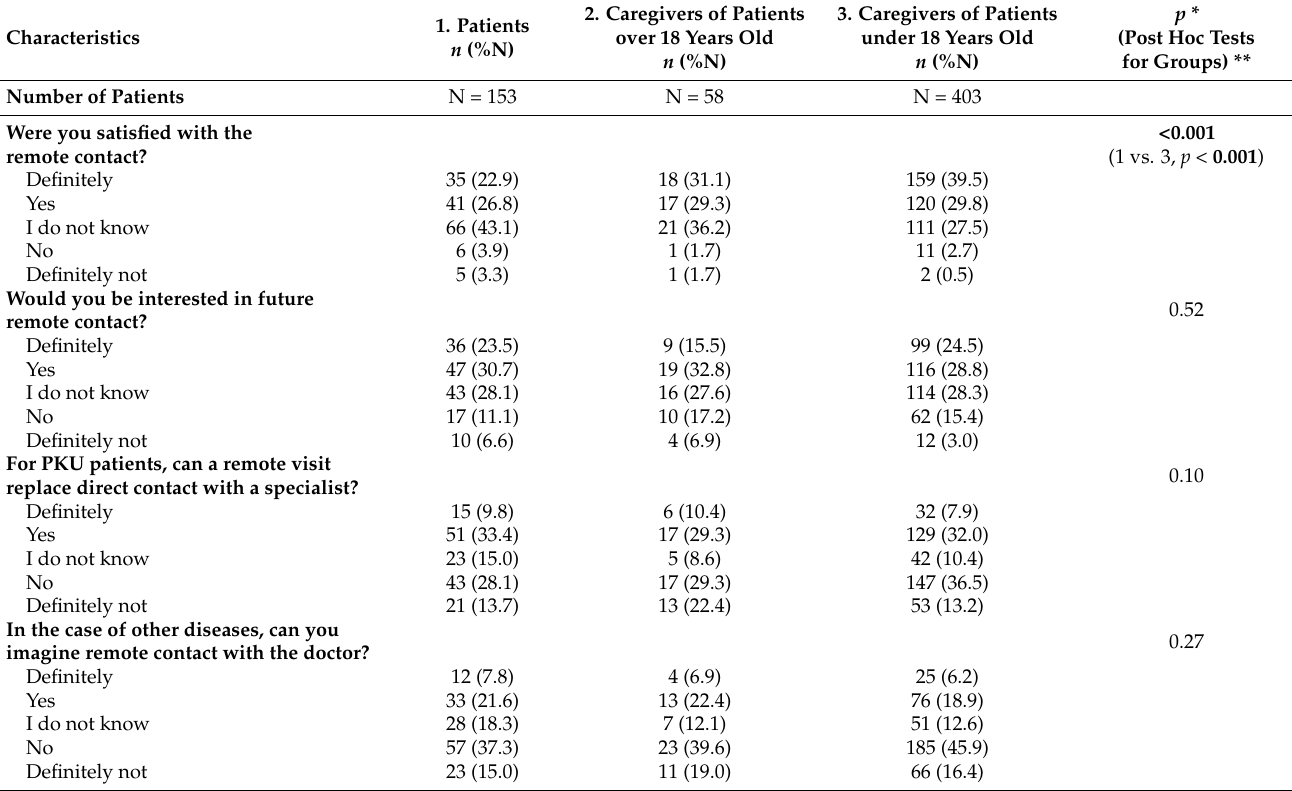
Table 4. Respondents’ perception of remote contact in PKU